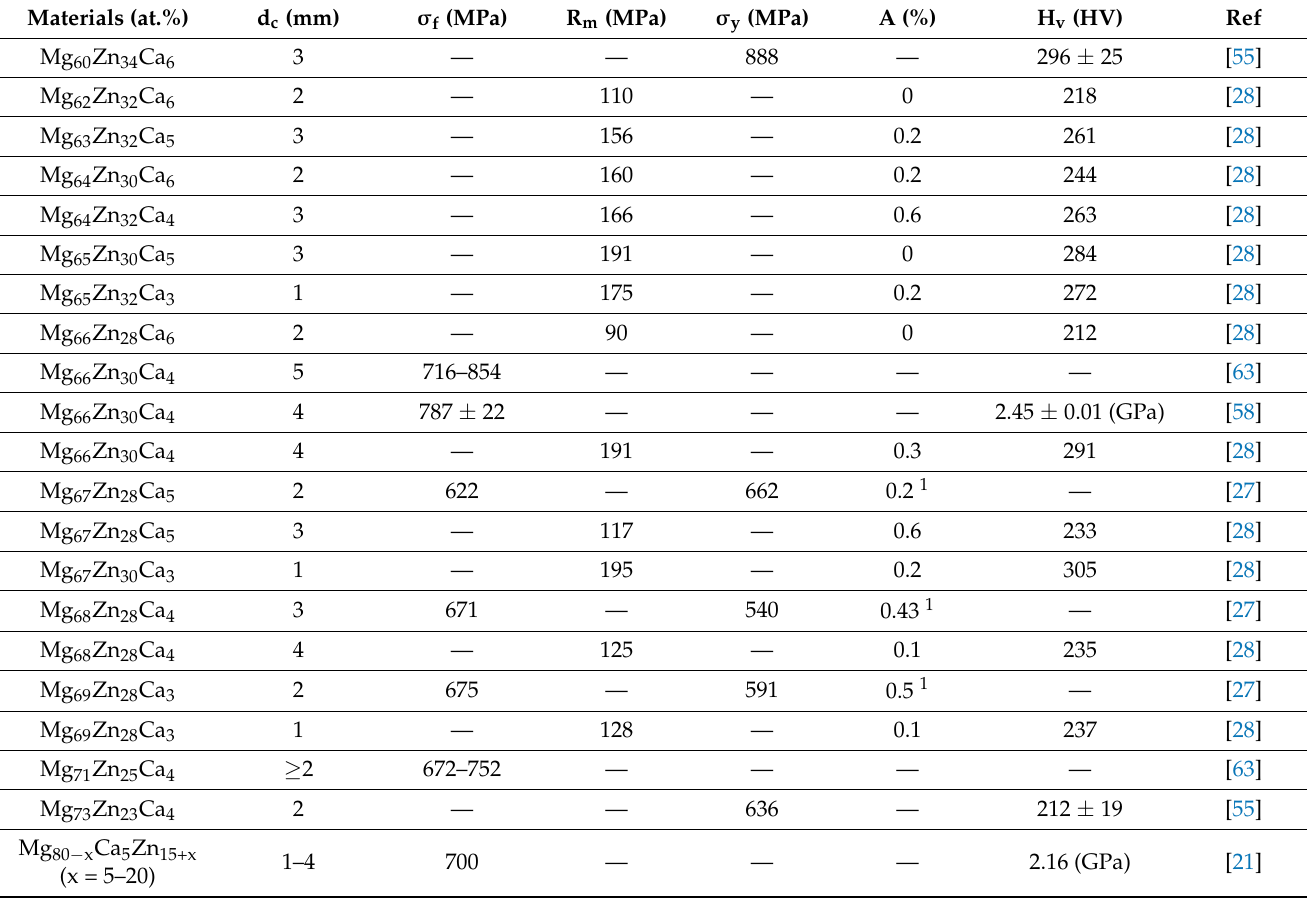
Table 1. Mechanical properties of Mg–Zn–Ca